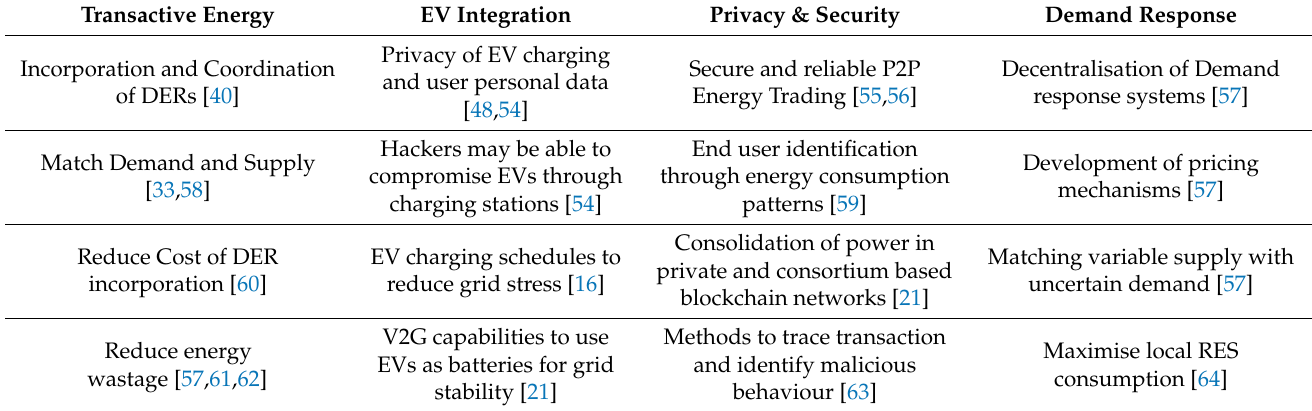
Table 5. Challenges for the application of energy blockchain